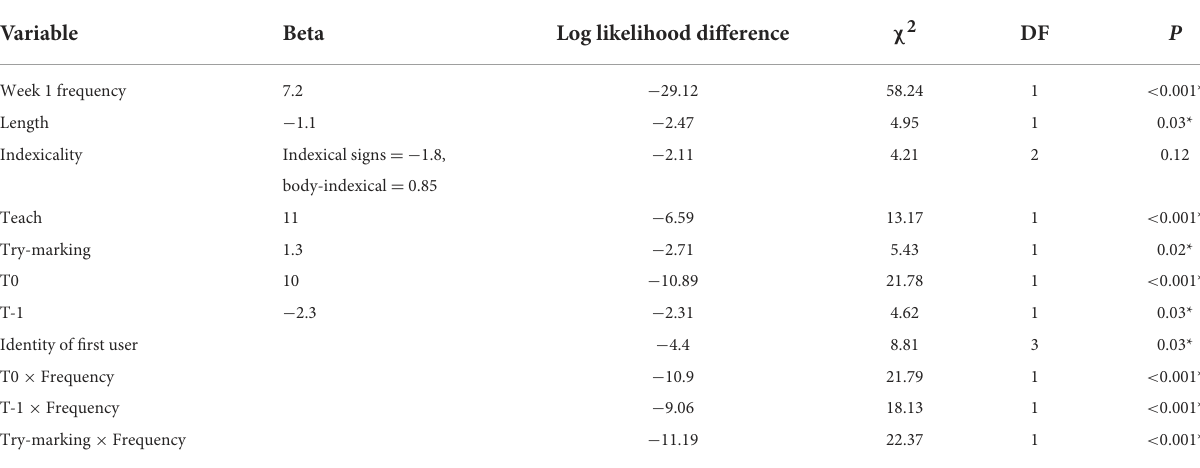
TABLE 2 Results of the model comparison tests for different